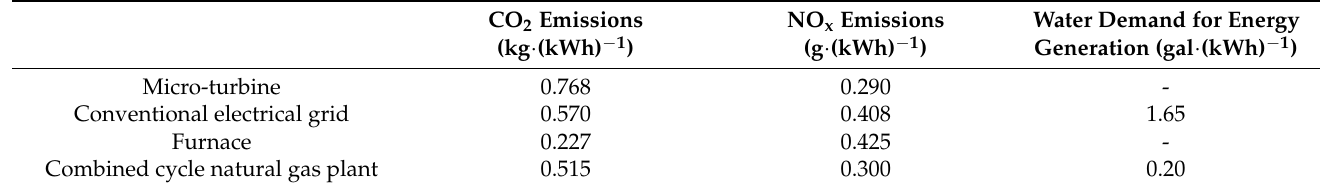
Table 7. Greenhouse gas emissions and water consumption for different sectors of energy generation